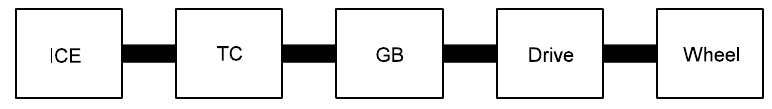
Figure 4. Schematic picture of the traditional powertrain